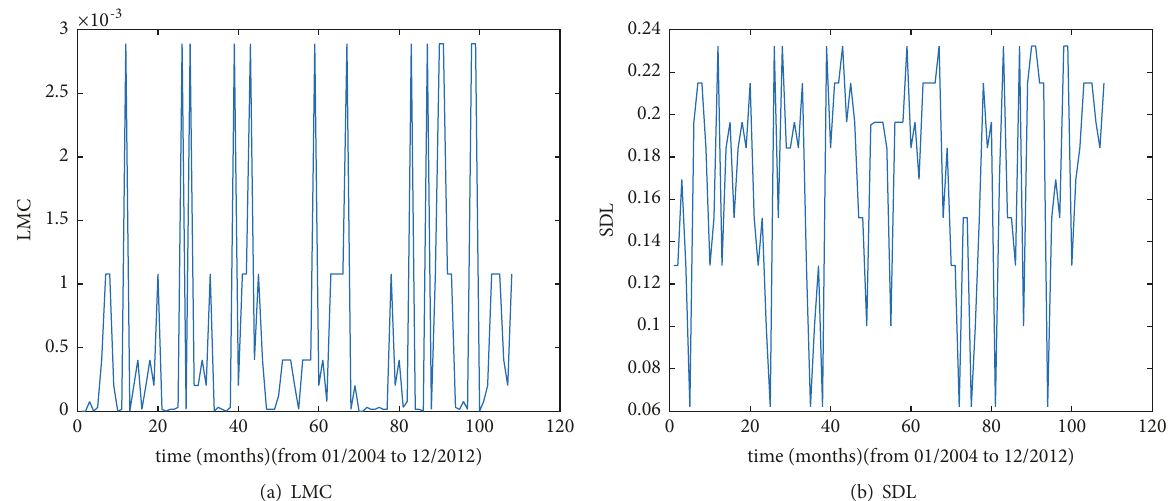
Figure 4: Temporal evolution of complexity (32-part